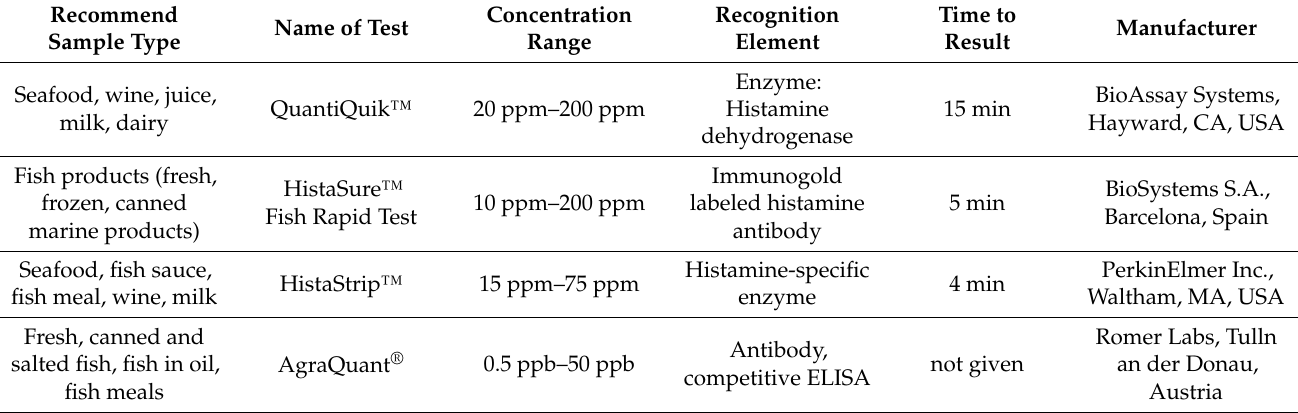
Table 5. Overview with examples of commercially available fast tests for histamine